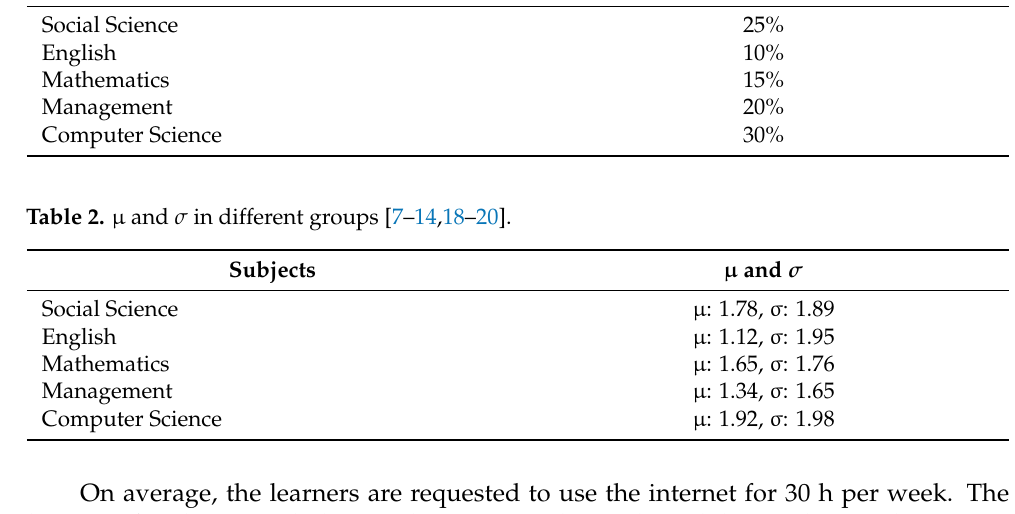
Table 1. Structure of the learner population [7–14,18–20]. Subjects Learner Size